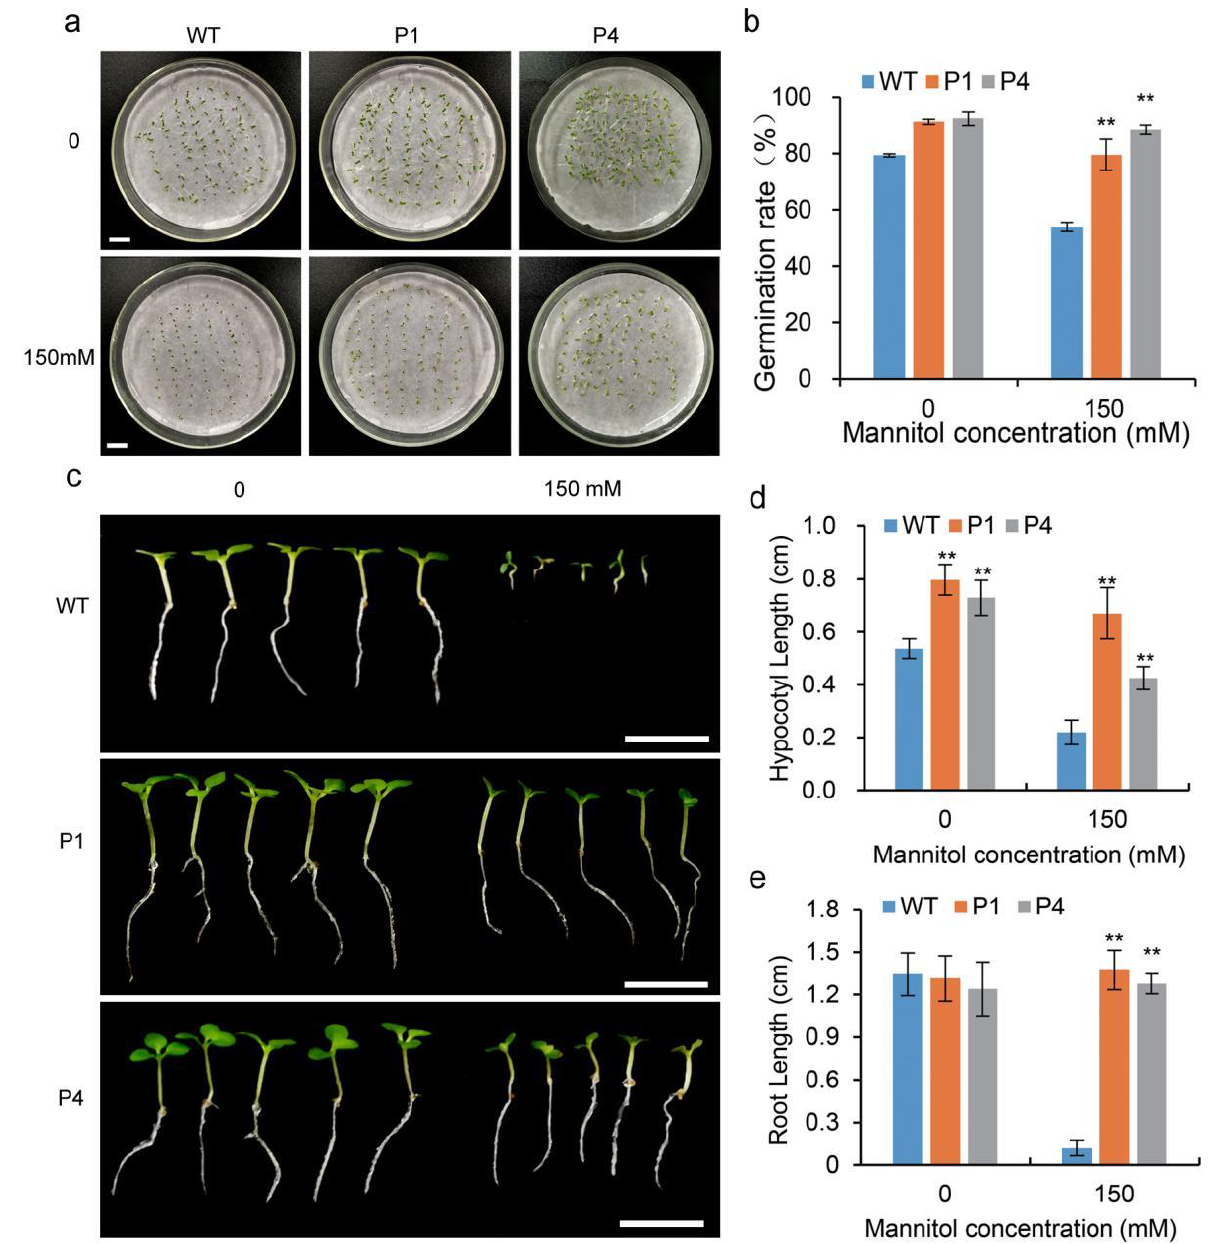
Figure 4. Transgenic lines (P1 and P4) and wild-type (WT) tobacco “K326” seedlings treated with 0 or 150 mM mannitol. ( a ) Germination of seeds (bar = 1 cm), ( b ) percentage germination of seeds, ( c ) phenotype of the seedlings after 15 days (bar = 1 cm), ( d ) hypocotyl length, and ( e ) root length. Data were analyzed statistically using SPSS. **P < 0.01.